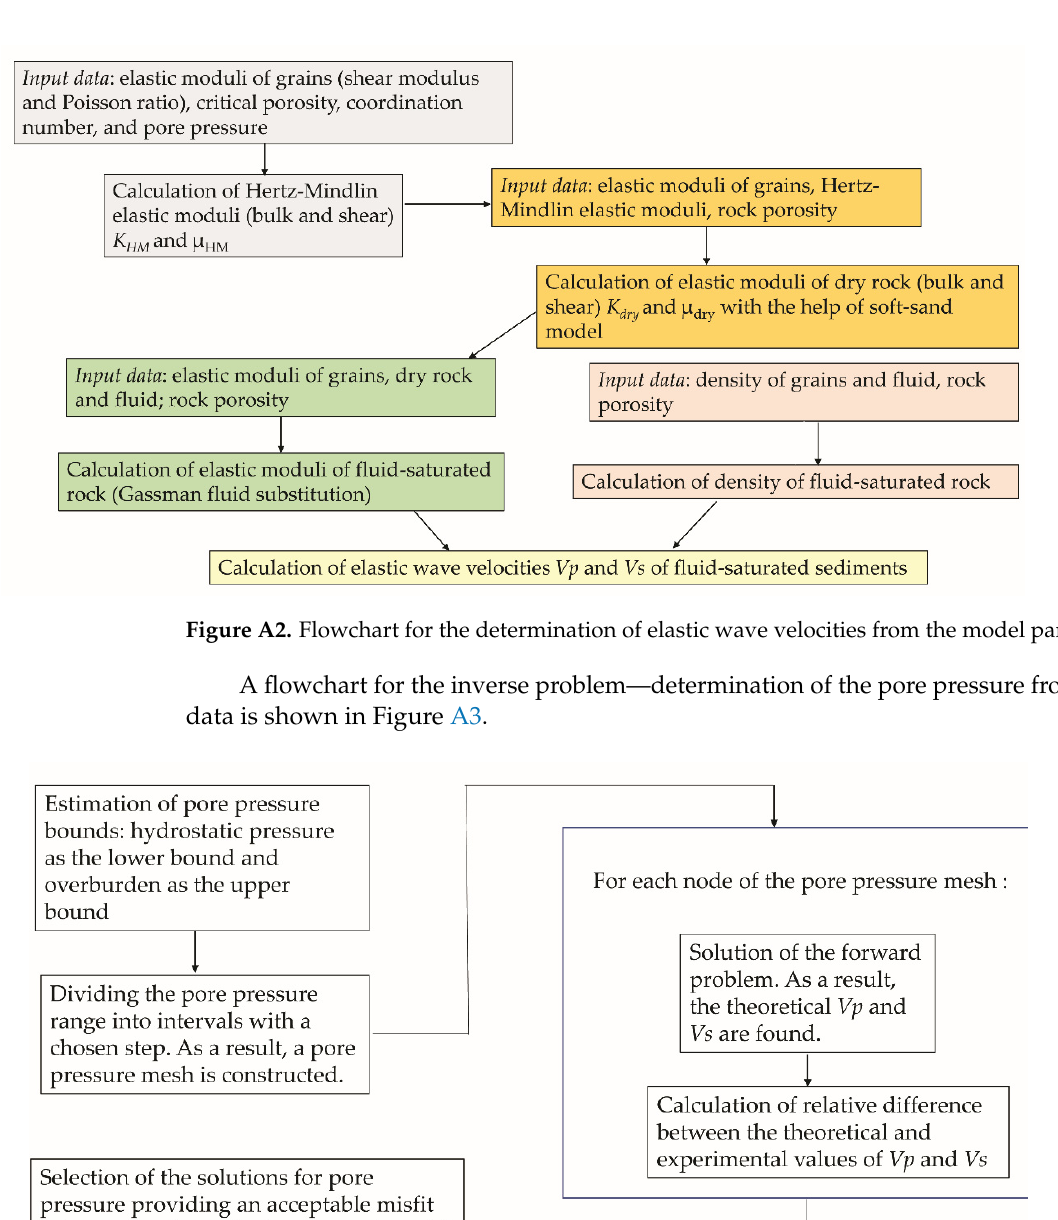
Figure A1. Flowchart for the determination of pore pressure through consolidation analysis. A flowchart for the forward problem solution—determination of elastic wave veloc- ities from the model parameters—is shown in Figure A2.